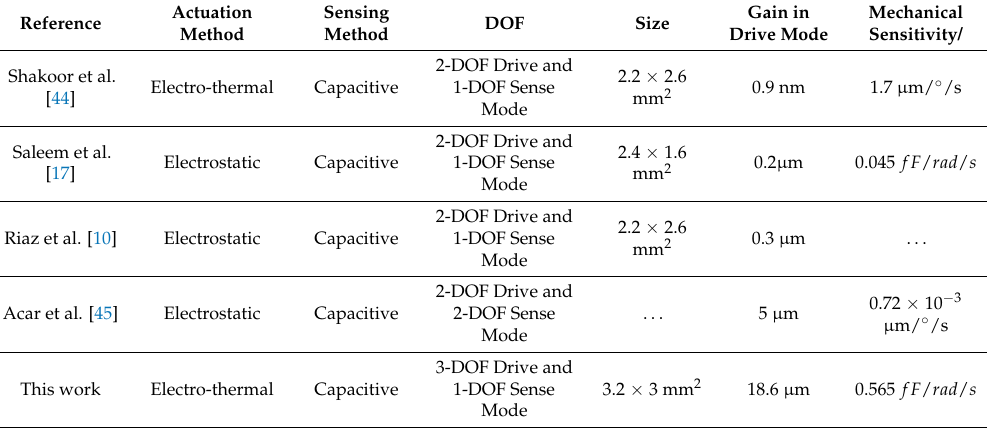
Table 6. Comparison of the proposed gyroscope with multi-DOF microgyroscopes presented in the